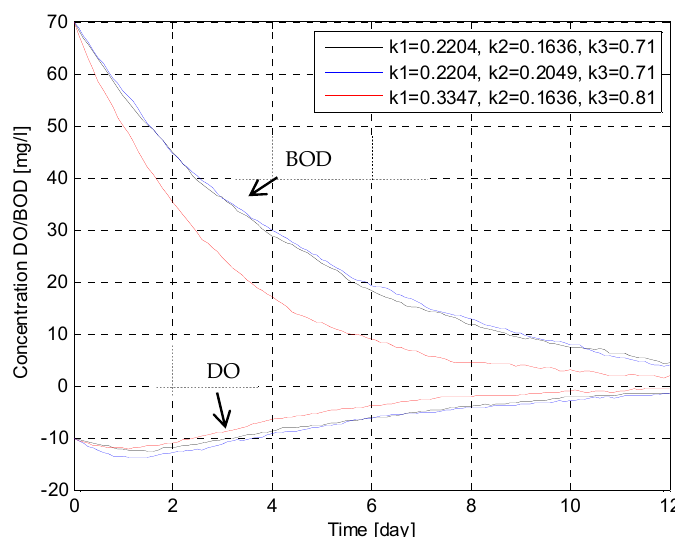
Figure 3. Distributions of waveform BOD and dissolved oxygen (DO) for different values of model parameters.